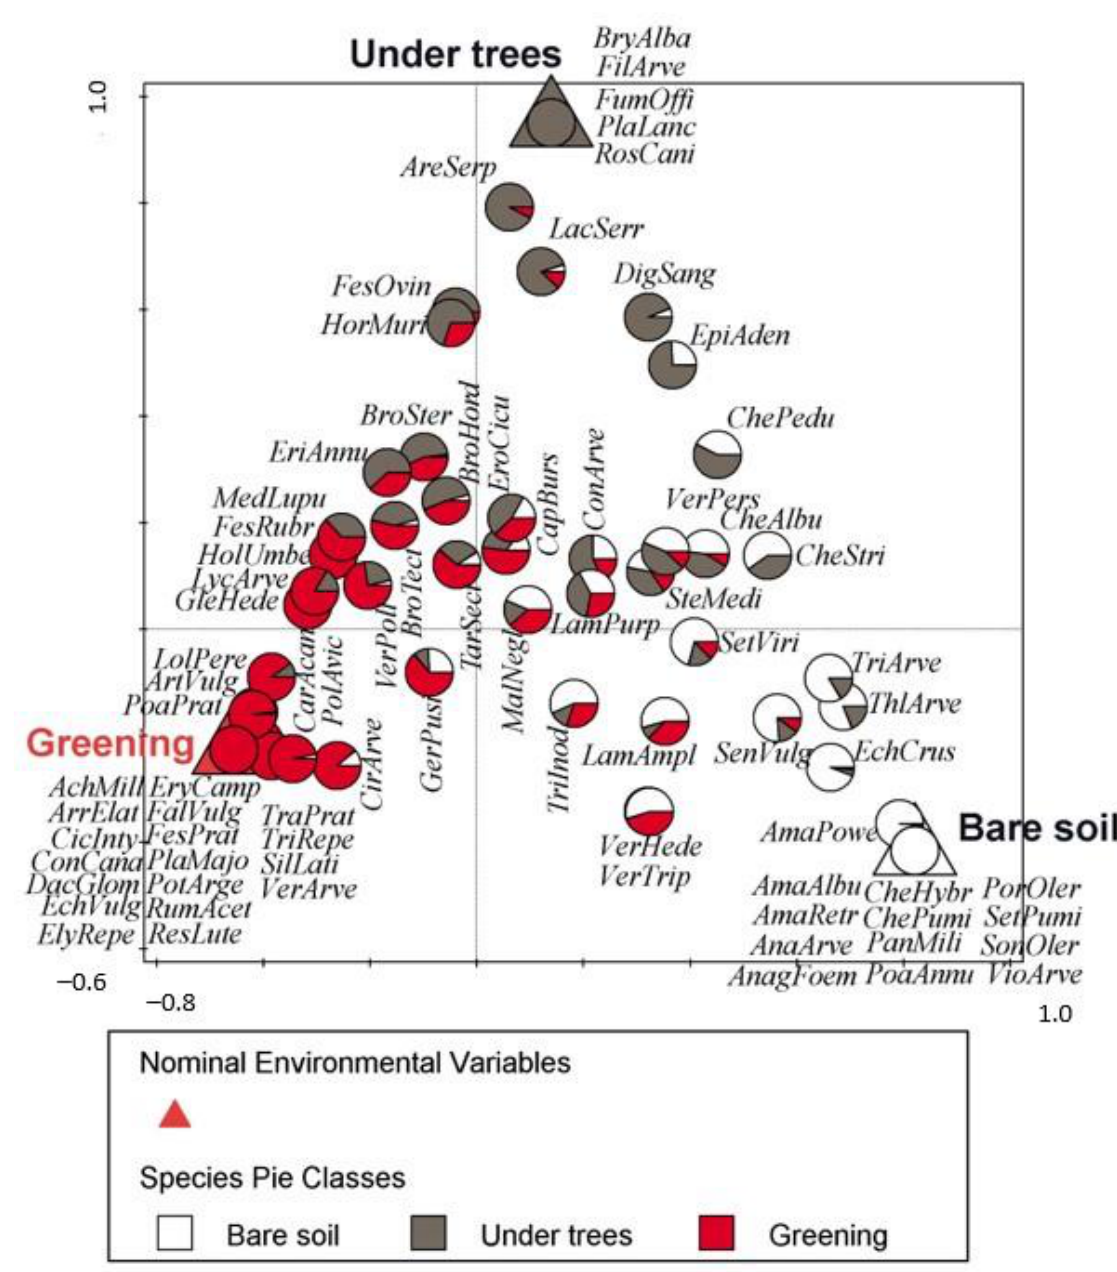
Figure 5. Occurrence of the plant taxa identified at the site with different management in the orchard. (Result of CCA analysis; total explained variability = 12.9%; F-ratio = 6.5; p -value = 0.001).